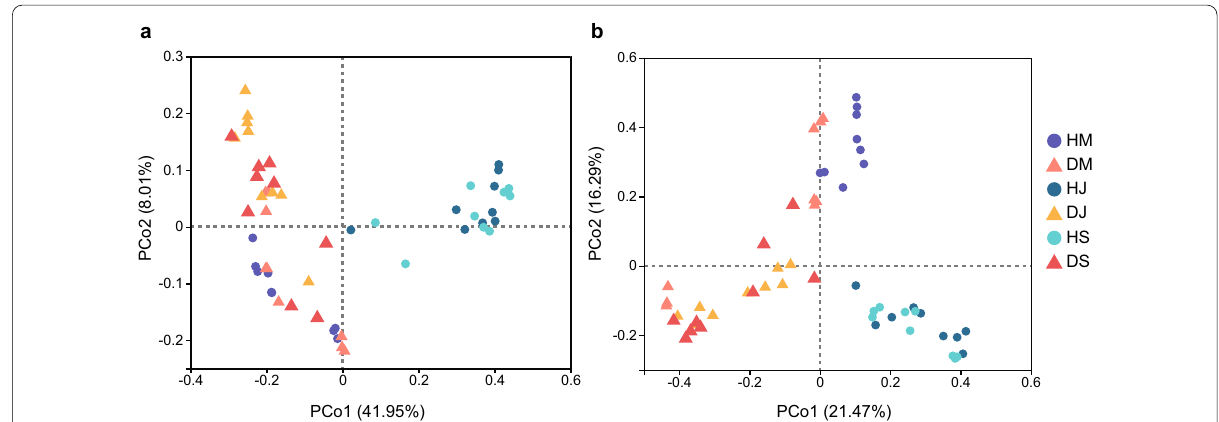
Fig. 2 PCoA of the soil a bacterial and b fungal community compositions. HM/DM: soils collected from healthy (H) and diseased (D) fields in March; HJ/DJ: soils collected from healthy (H) and diseased (D) fields in July; HS/DS: soils collected from healthy (H) and diseased (D) fields in